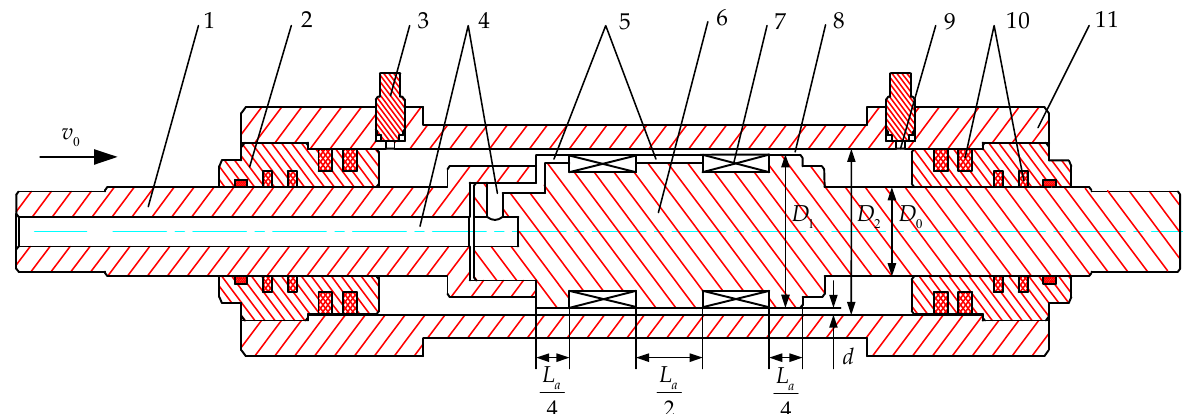
Figure 1. 2D structure schematic of the MRA.